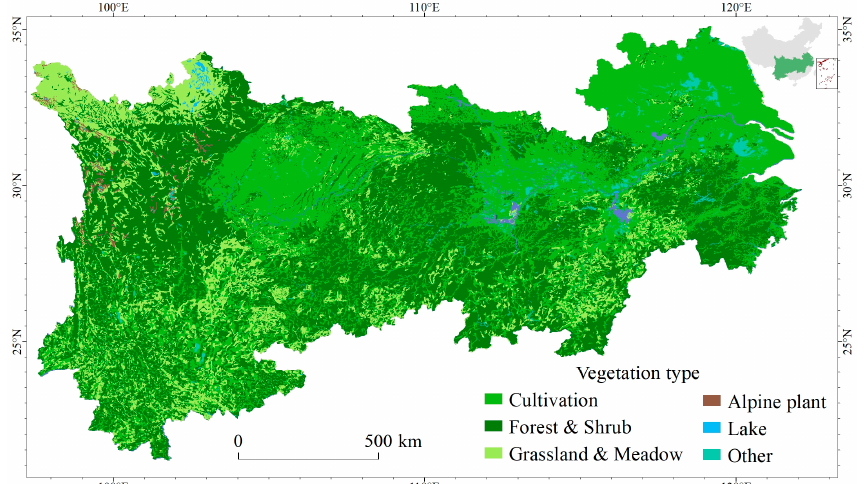
Figure 1. The vegetation types in the YREB (Plant science data center, Chinese Academy of Sciences (edited by Zhang Xinshi), 2007) and the location of the study area in China (green shading in the top-right corner).